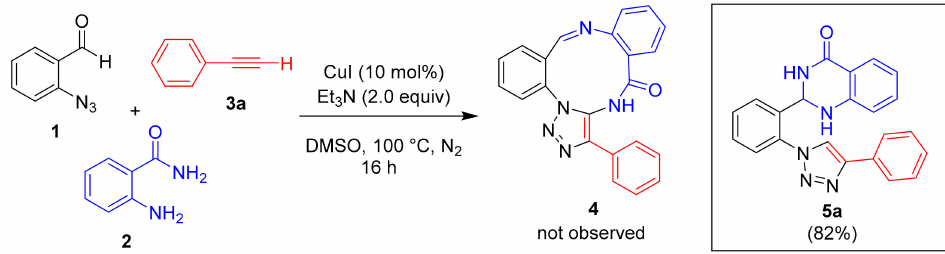
Figure 3. Synthesis of triazoylquinazolinone 5a .